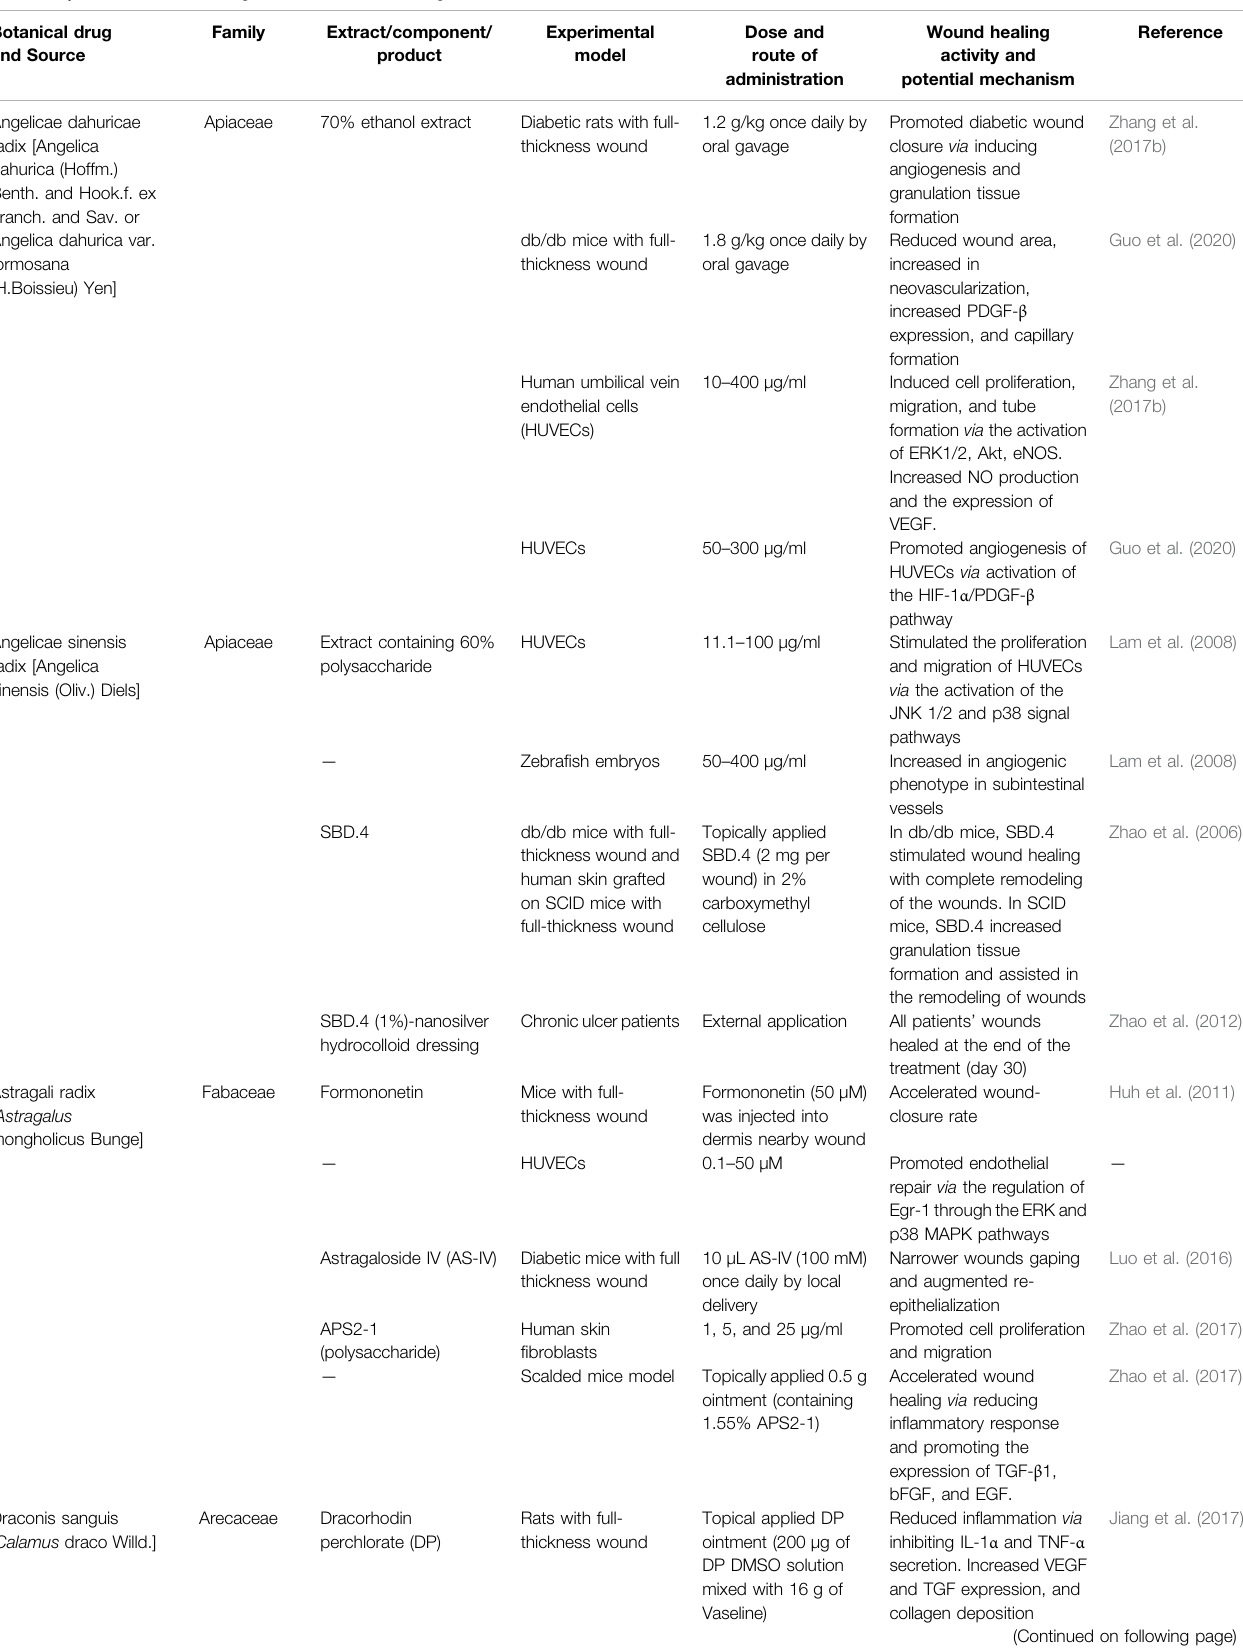
TABLE 1 | Chinese botanical drugs and their wound healing activities. Botanical drug and